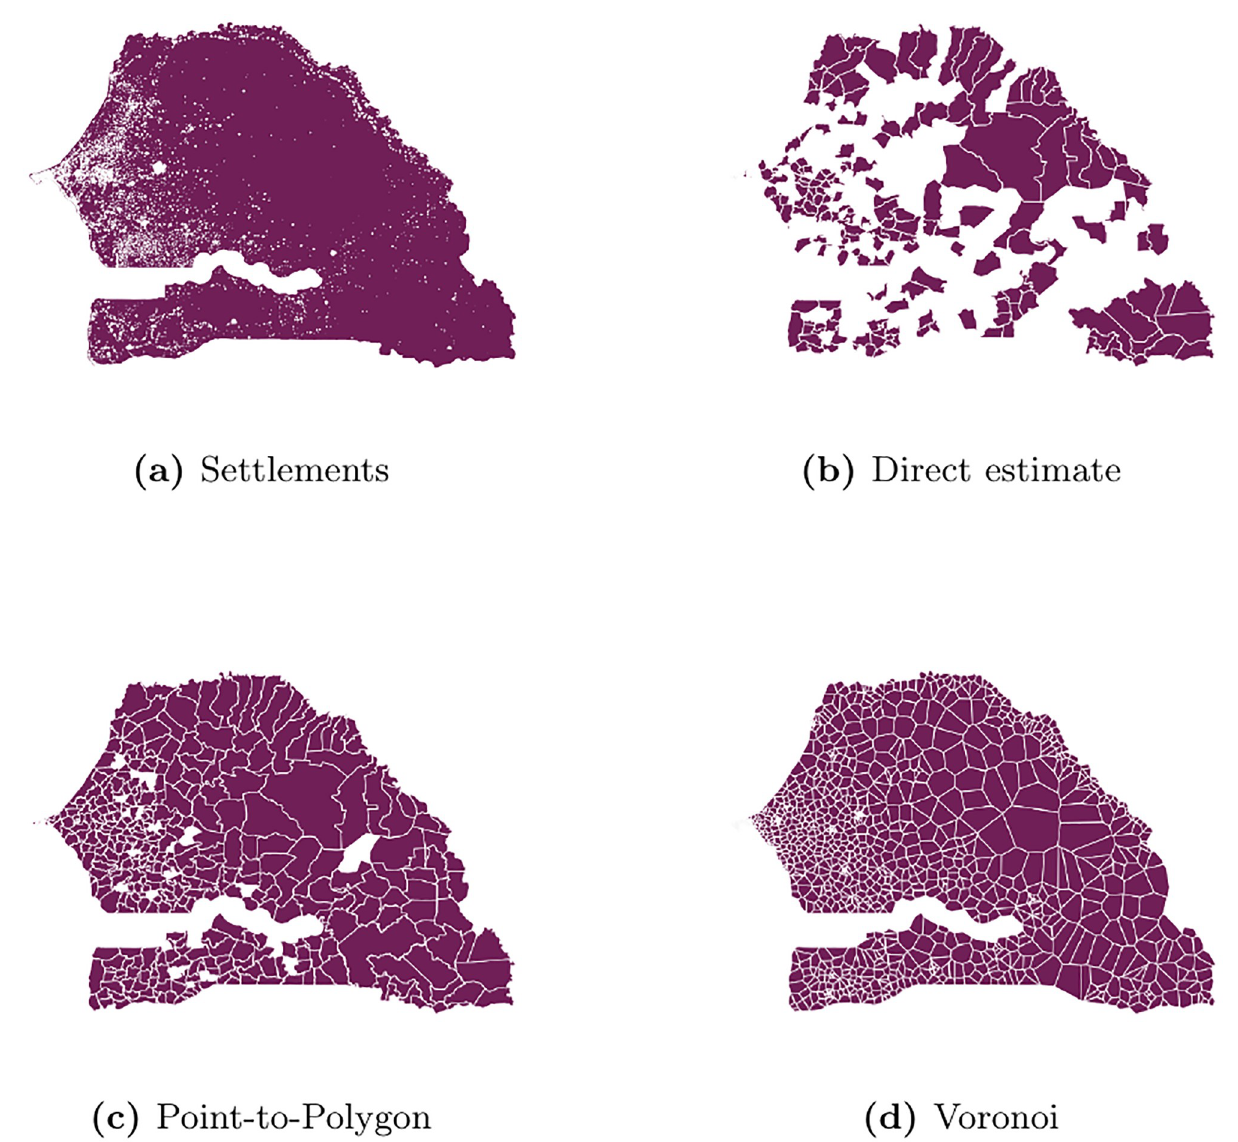
Fig 8. Commune-level coverage areas in Senegal. Areas for which estimates of indicators of interest are available are coloured in red. Lower resolution built-settlements extents data reprinted from [10] under a CC BY license, with permission from WorldPop, original copyright 2018, are used in (a) for illustrative